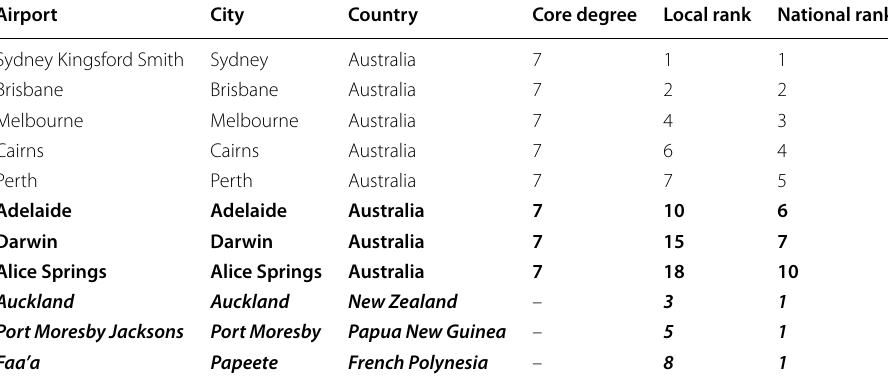
Airports not in the top 8 regional hubs are in bold. The core degree of a node is its number of links in the maximum k-core. Local rank is the rank in the large local component. National rank is the airport rank in its country. Airports in the top 8 regional hubs and not in the k-core are in bolditalic